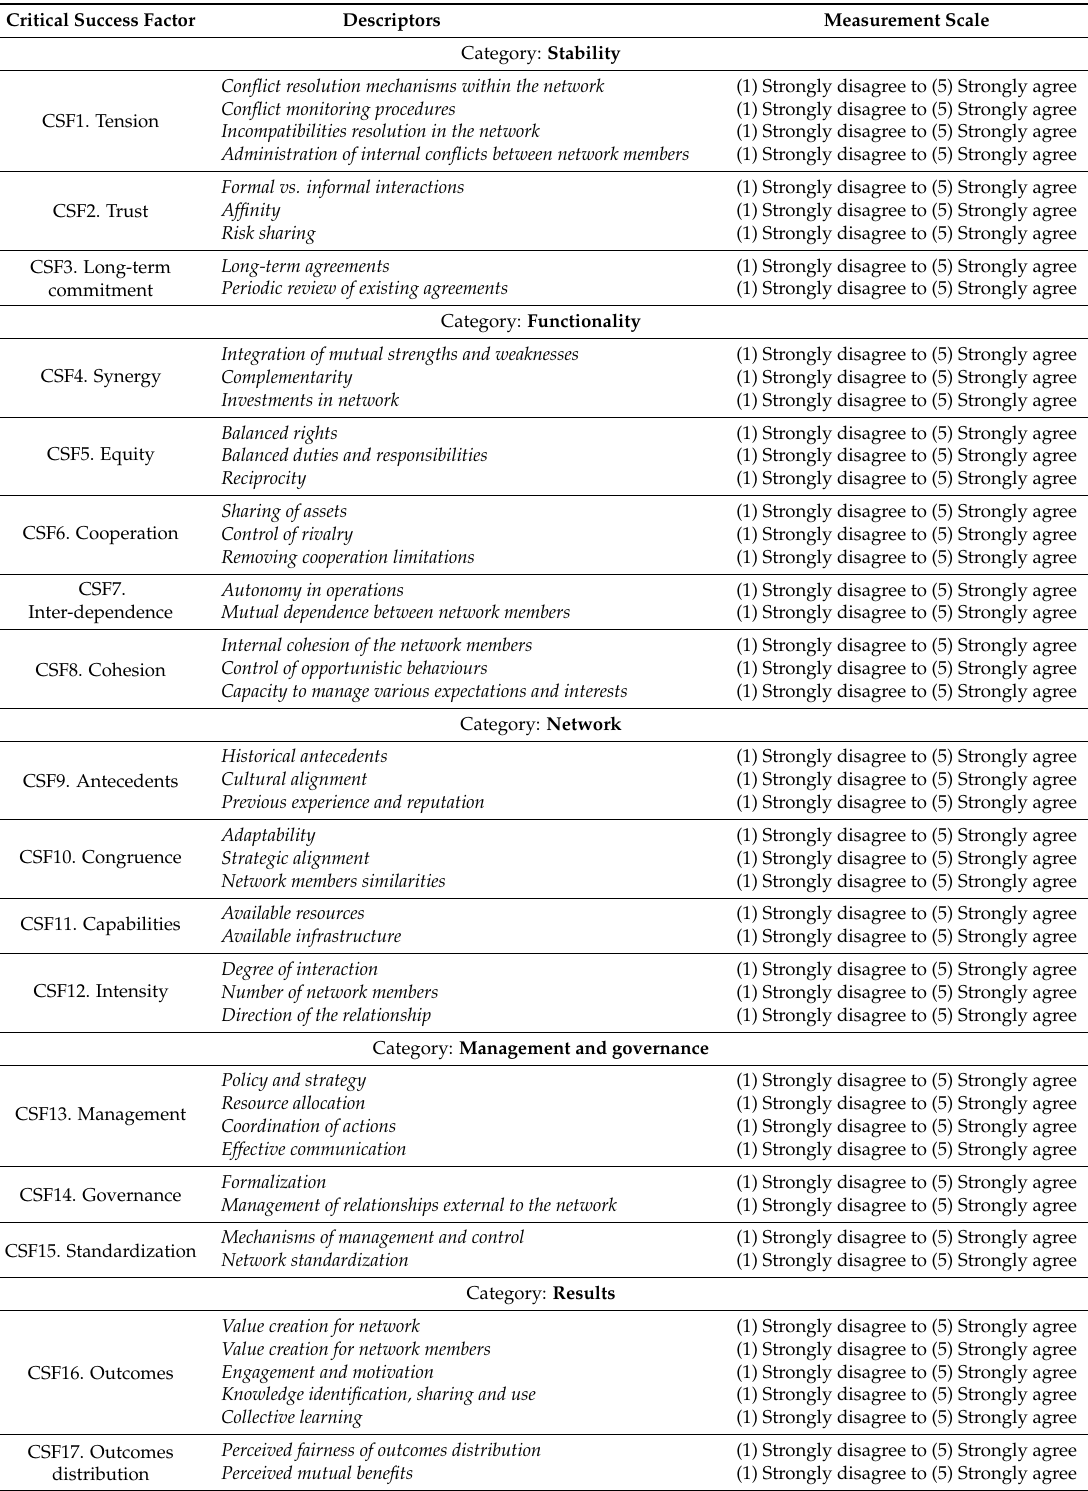
Table 2. Measurement scale and descriptors for Critical Success